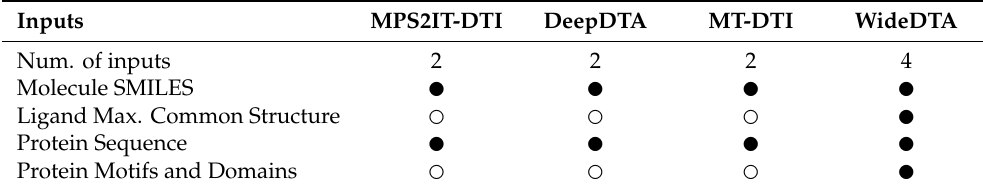
Table 6. MPS2IT-DTI model compared to baselines according to the representation of the inputs: (M) molecules and (P) proteins.